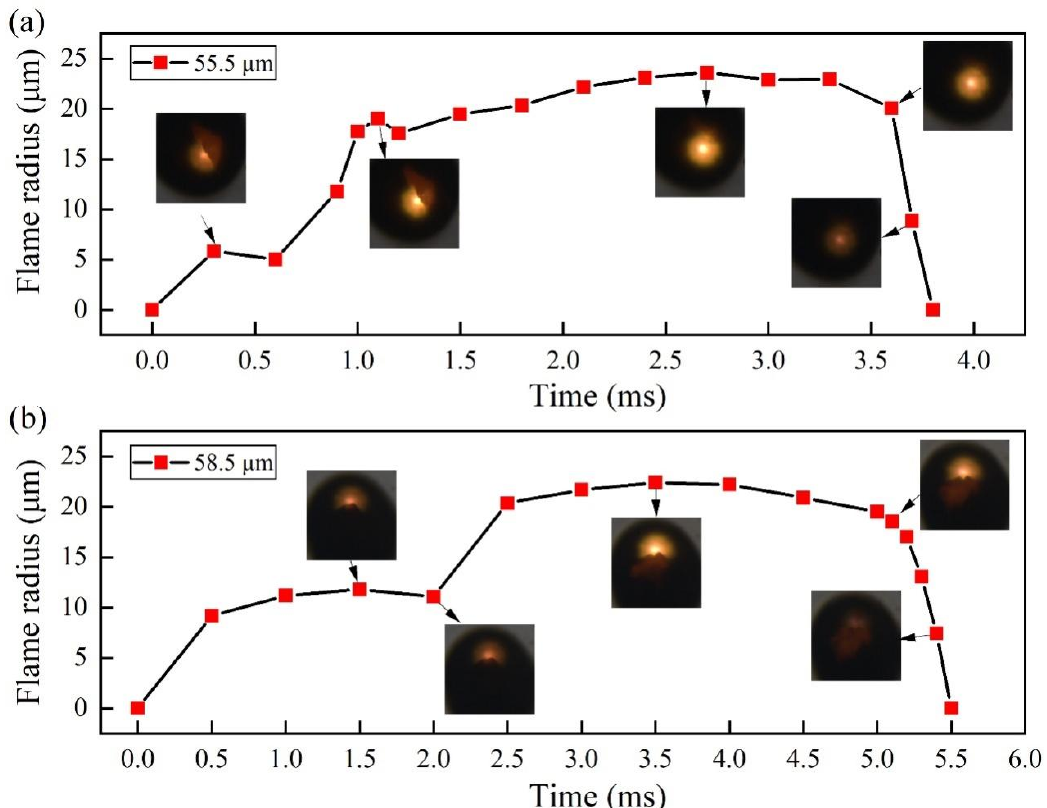
Figure 9. Flame propagation rates of individual Mg microparticles burned in air. ( a ) particle of 55.5 μ m; ( b ) particle of 58.5 μ m.